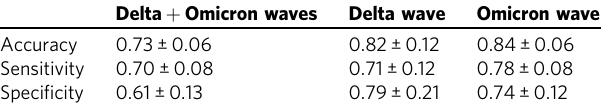
Table 3 PLS-DA results showing mean ± standard deviation values for validation sets after 50 iterations of each model, built on the 63 VOCs presented in Supplementary Data